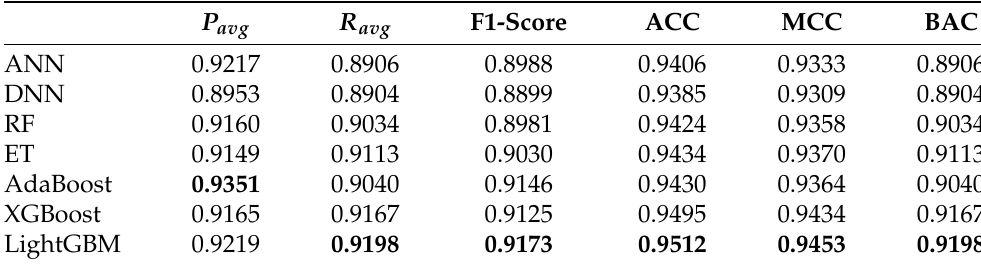
Table A3. Measured metrics for permission set S64.